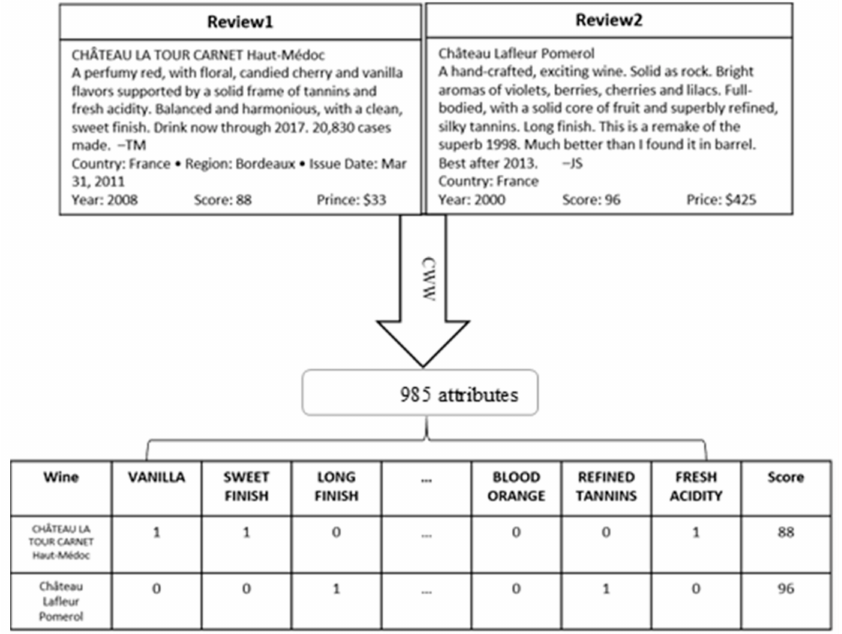
Figure 2. The flowchart of converting reviews into machine language understandable through the computation wine wheel. All key word appearances for a review are initially recorded as a 0. When a key word is found within the review, it is recorded in the table as a